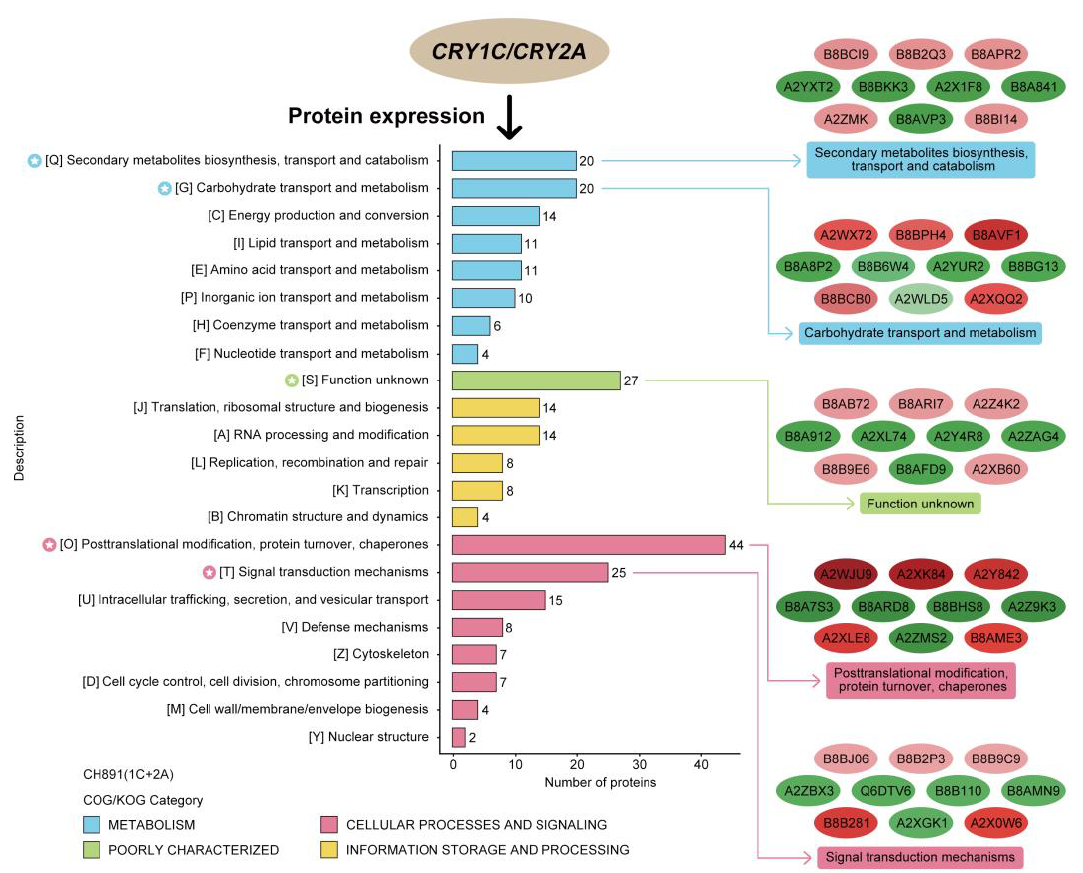
Figure 7. Cluster analysis of differentially expressed proteins (DEPs). Clusters of Orthologous Groups of proteins (COG) displayed the degree of accumulation of conserved proteins among samples of NIL groups CH891(1C+2A).